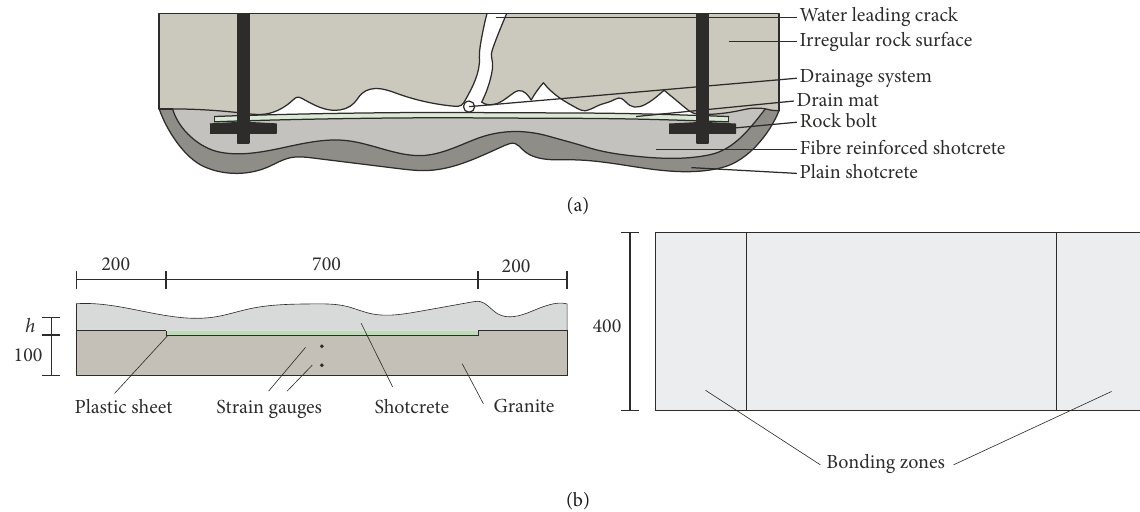
Figure 4: (a) shows the in situ principle of a drainage system with synthetic drain mats. (b) shows test setup for shrinkage cracking testing [17] of shotcrete slabs with varying thickness. Vertical and horizontal view. Measurements in (mm).